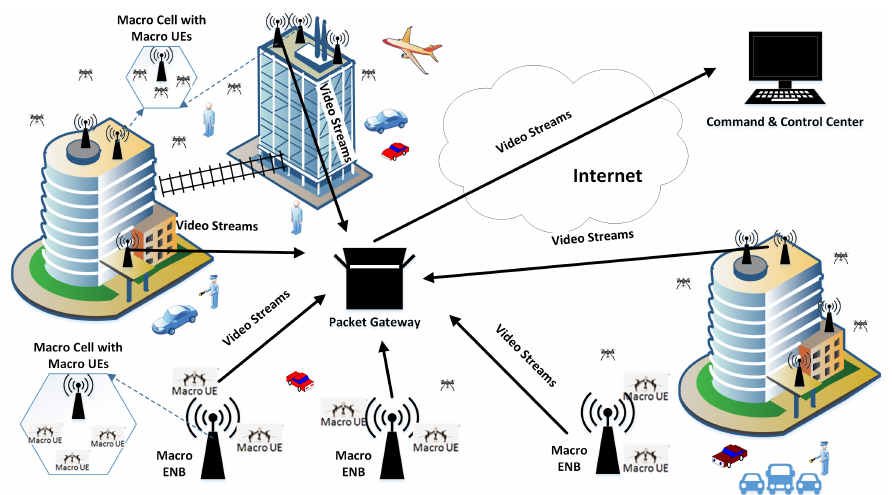
Figure 1. Surveillance system comprising